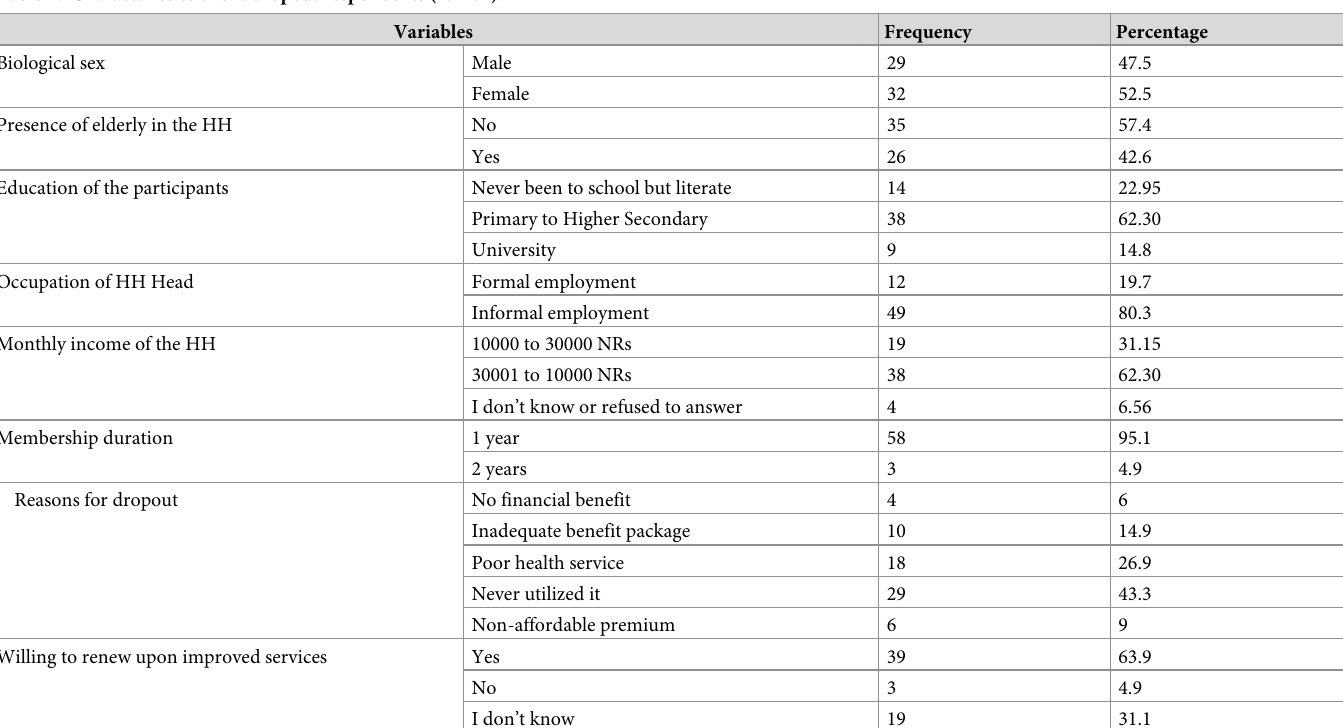
Table 4. Characteristics of the dropout respondents (N =